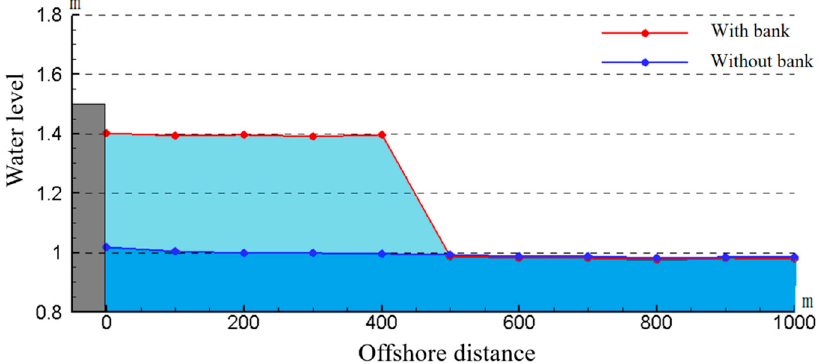
Figure 11. Comparison of water level in the sea area outside the embankment.